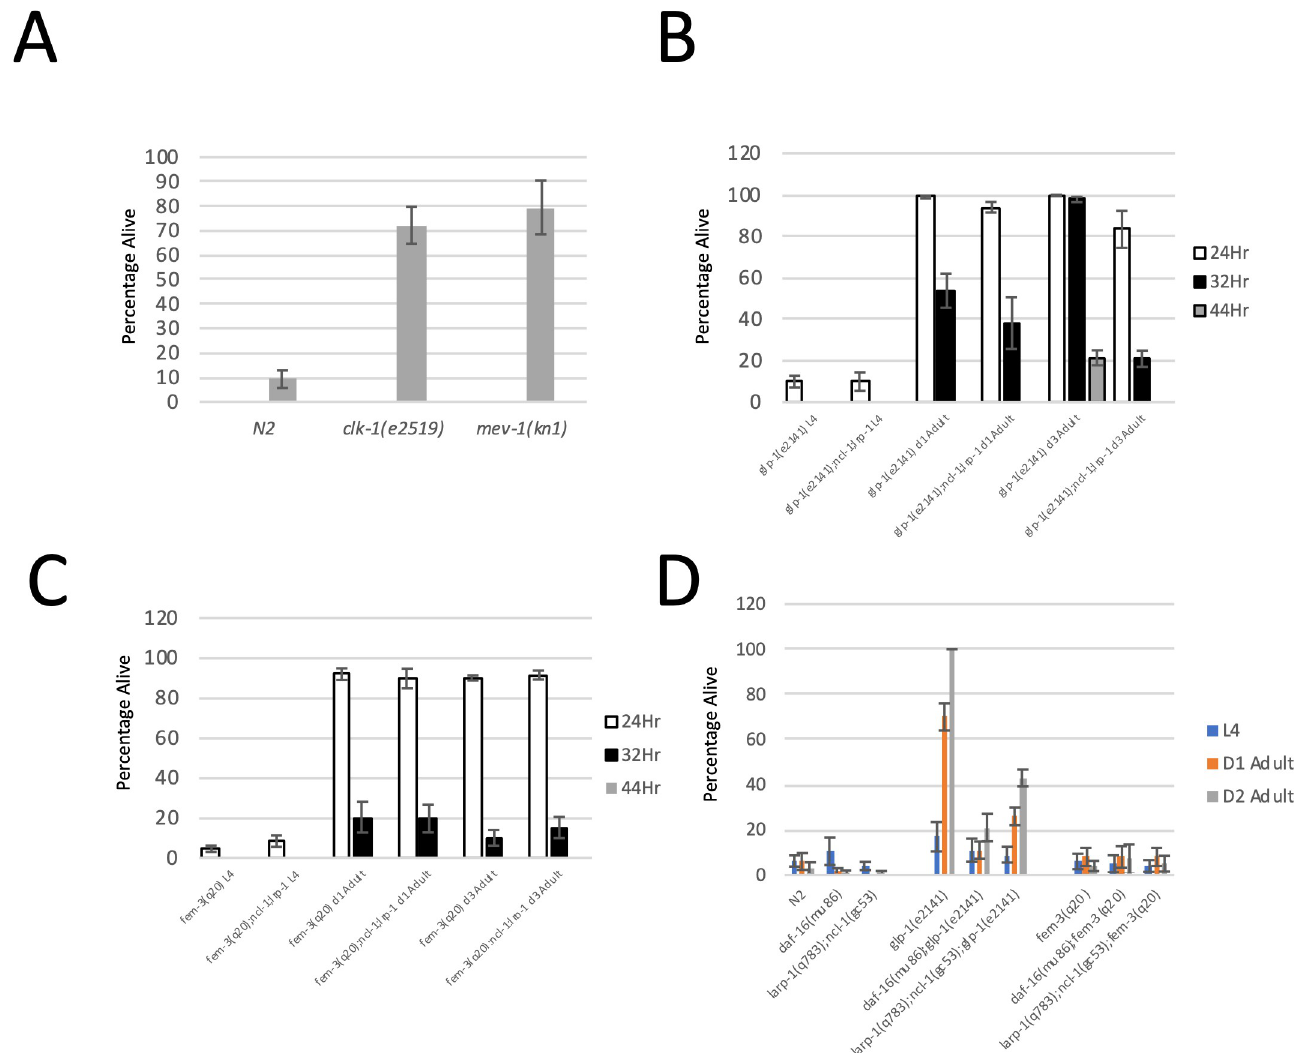
Fig 7. Potential Mechanisms of glp-1(e2141) Super Resistance. (A) Hypoxia resistance of oxidative phosphorylation mutants. Data show that both clk-1 and mev-1 mutants are highly resistant to hypoxic injury. Data are derived from at least 4 biological replicates. (B) Percentage of glp-1 mutant worms surviving 24, 32, and 44 hours of hypoxia. Mutation of ncl-1 and l arp-1 together does not suppress the day 1 adult hypoxia resistance of glp-1(e2141) mutants, but completely suppresses the aging dependent super resistance of day 2 glp-1(e2141) mutants. (C) Percentage of worms surviving 24, 32, and 44 hours of hypoxia. Fem-3(q20) mutants become more resistant to hypoxia on day 1 of adulthood, but do not become super resistant by day 2 of adulthood. Mutation of ncl-1 and larp-1 together does not suppress the hypoxia resistance of day 1 or day 3 fem-3(q20) adults. Data represent 6 biological replicates. (D) Percentage of worms surviving heat stress (10.5 hours at 35˚C). glp-1(e2141) day 1 adults survive 10.5 hours of heat stress, whereas L4 worms do not. Mutation of daf-16 suppresses the heat resistance of glp-1(e2141) worms. Neither fem-3(q20) adults or L4 larvae survive 10.5 hours of heat stress. Data represent 4 biological